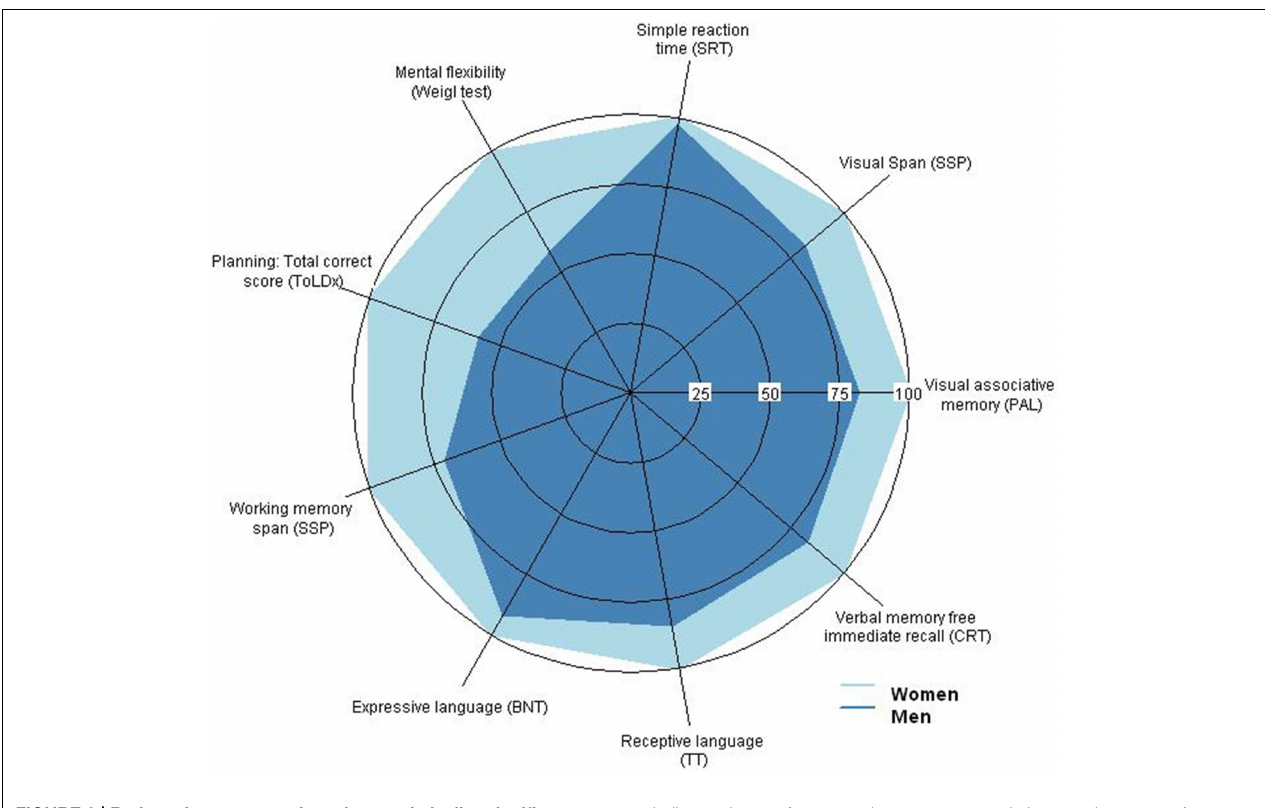
indicate the performance in percentage relative to the women’s performance, which has been set to 100%. Men with DS performed significantly poorer than women in all four cognitive